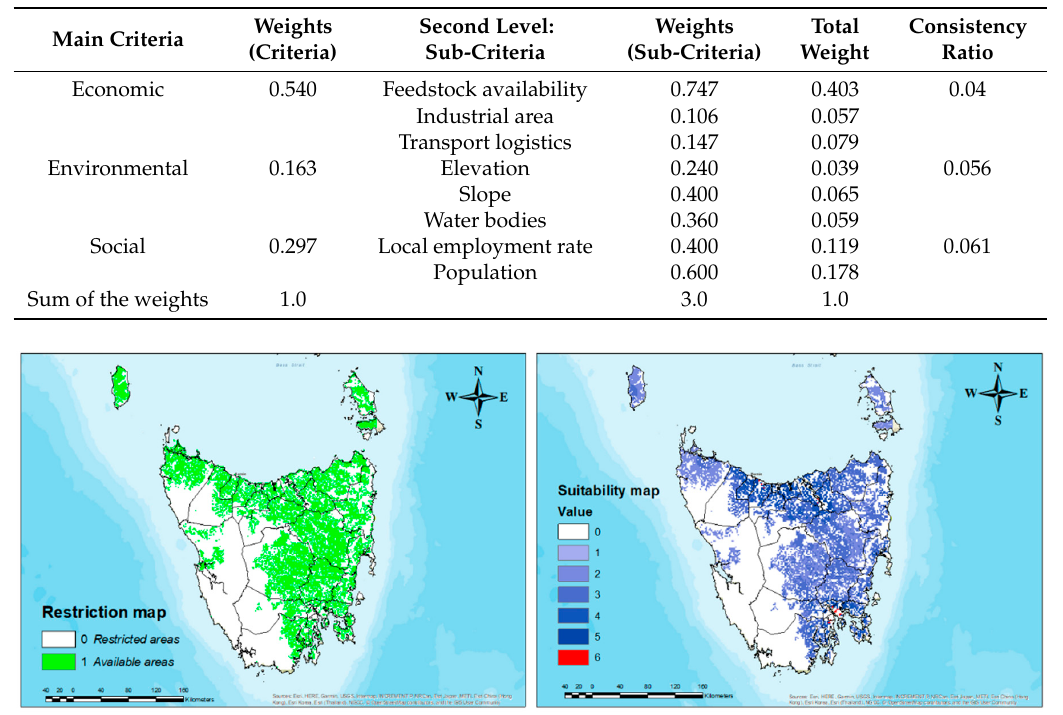
Table 3. Weights and preference factors in the Analytical hierarchy process (AHP) procedure.